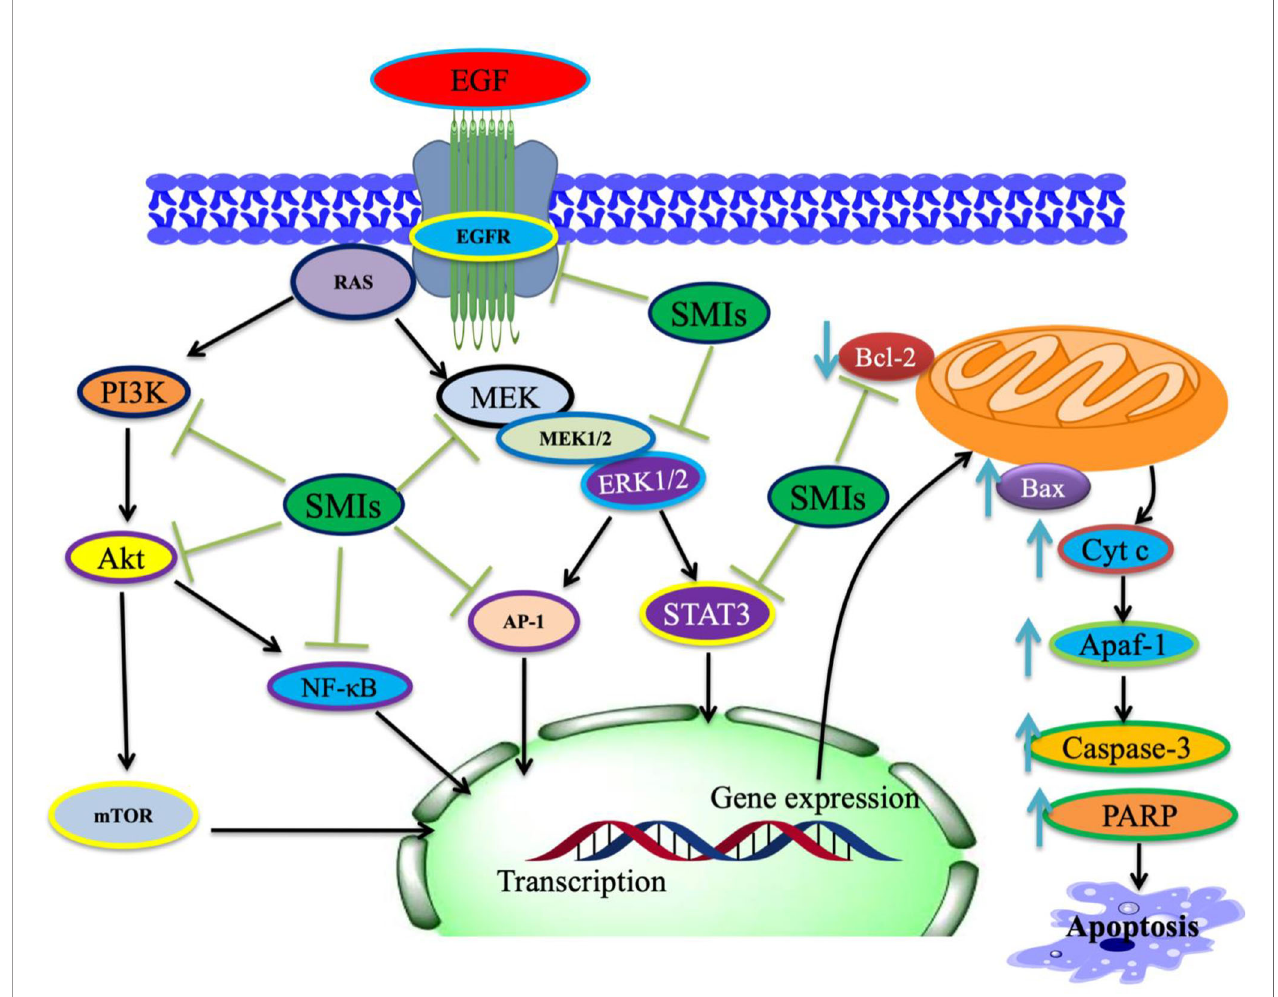
FIGURE 3 | The proposed possible mechanism of small molecule inhibitors (SMIs)/phytochemicals in EGFR-mediated pathways along with Bax/Bcl-2 cascade in NSCLC cells. SMIs, small-molecule inhibitors. (This fi gure is adapted from Ref 97, 133). This fi gure was drawn by